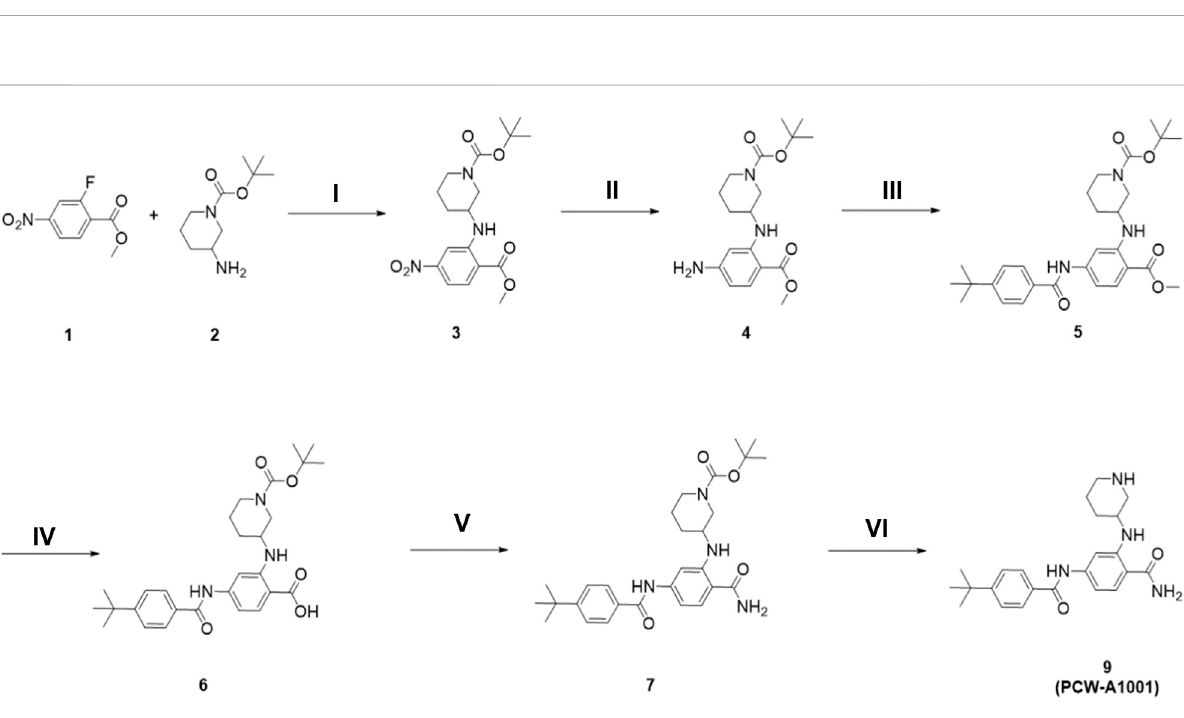
SCHEME 1 ThesynthesisofPCW-A1001.(i)K 2 CO 3 ,DMF,70 ° C,12 h;(ii)H 2 (g),Pd/C,EtOAc,r.t.,10 min;(iii)4-tert-butylbenzoicacid,EDCI,DMAP,DCM,r.t., 48 h; (iv) LiOH · H 2 O, THF/MeOH/H 2 O, r.t., 12 h; (v) NH 4 Cl, HBTU, DIPEA, DMF, r.t., 12 h; (vi) 20% TFA in MeOH, r.t., 3